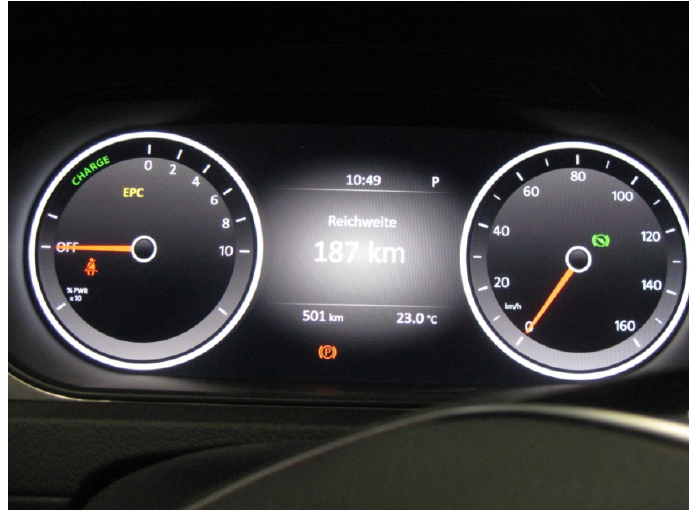
Figure 2: Free configurable dashboard display.